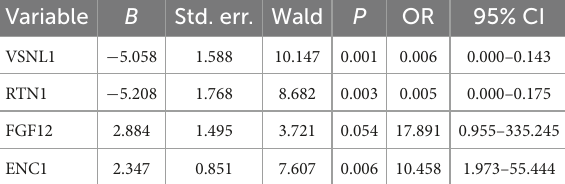
TABLE 6 Logistic regression analysis of four key